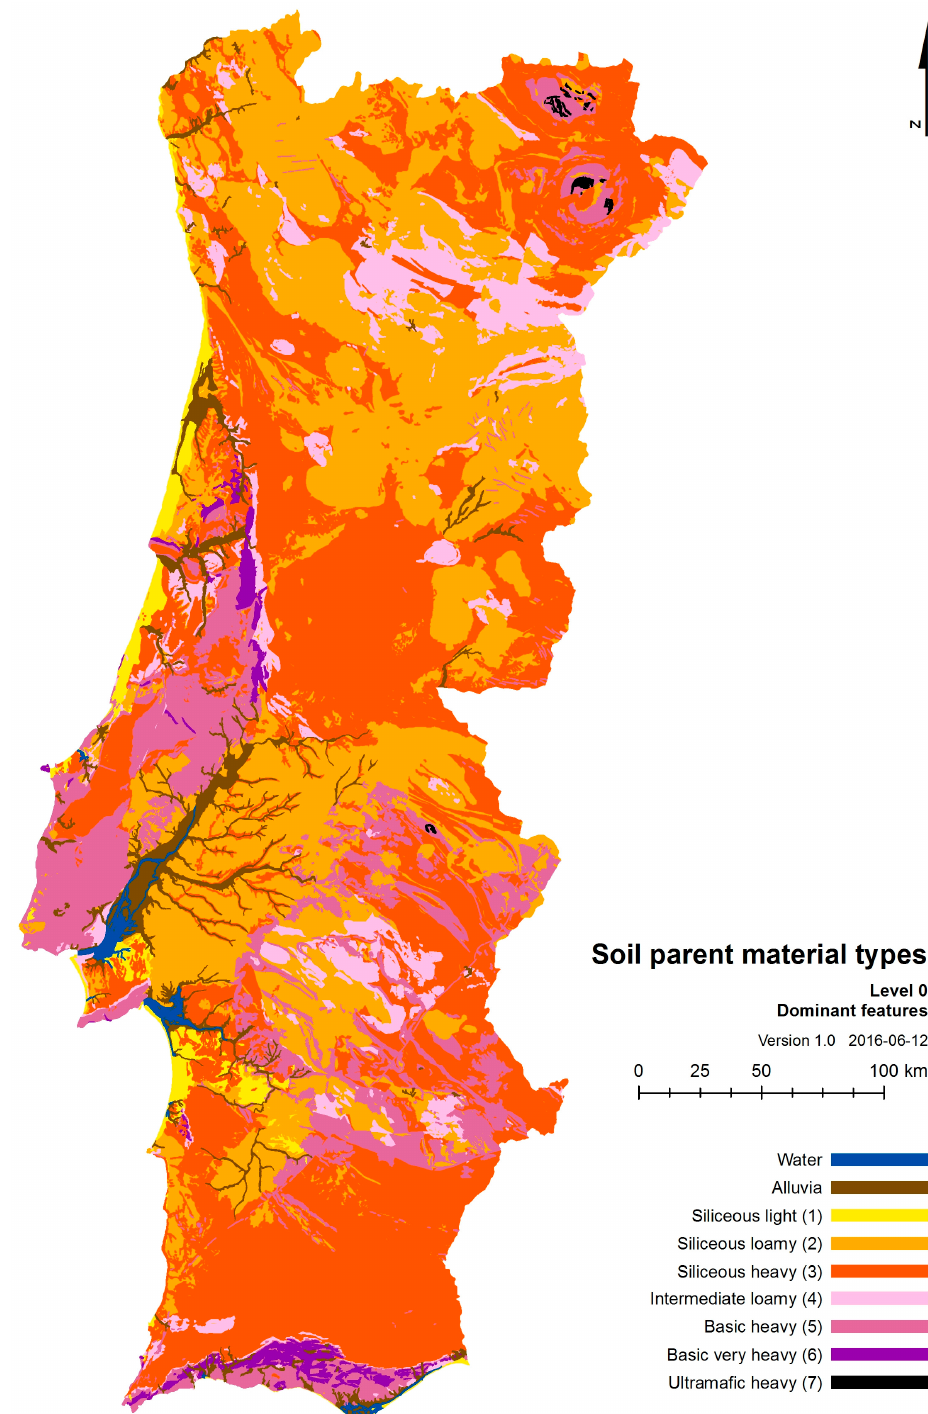
Figure A1. Soil parent material types map. The map contains other two classes: “alluvia” which are not easily classifiable within any of the defined classes, as their chemical composition and texture vary and “water”, corresponding to rivers, estuaries, etc.